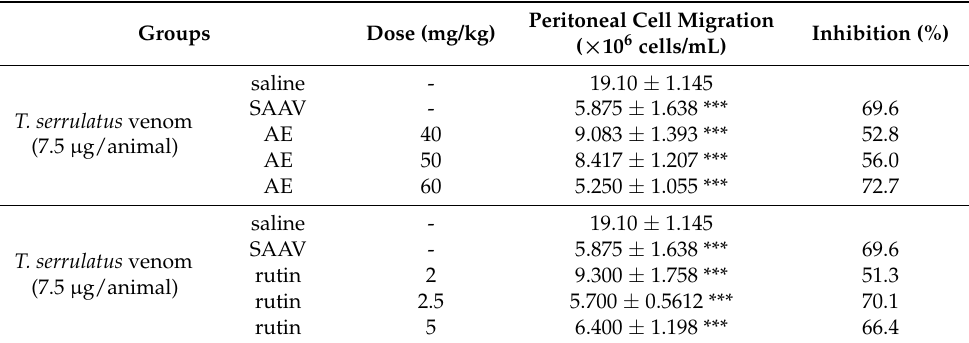
Values are mean ± standard deviation (S.D.), n = 5, *** p < 0.001, compared to venom group. SAAV: Serum Arachnid antivenom (1 Serum Arachnid antivenom (1 mg/mL).